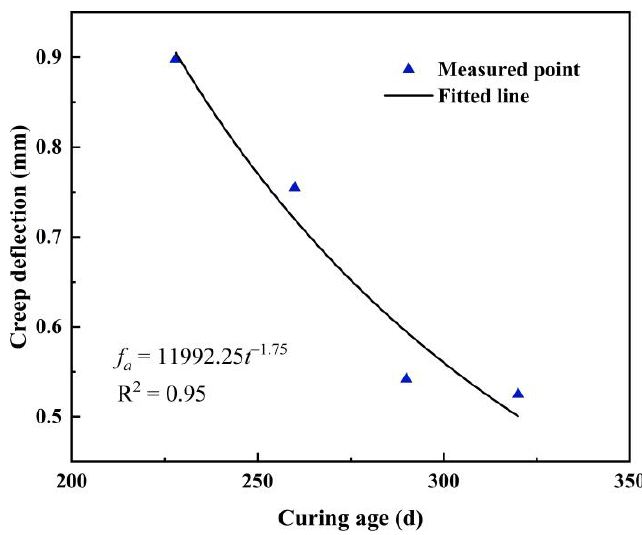
Figure 13. Effect of age of maintenance on creep deflection.